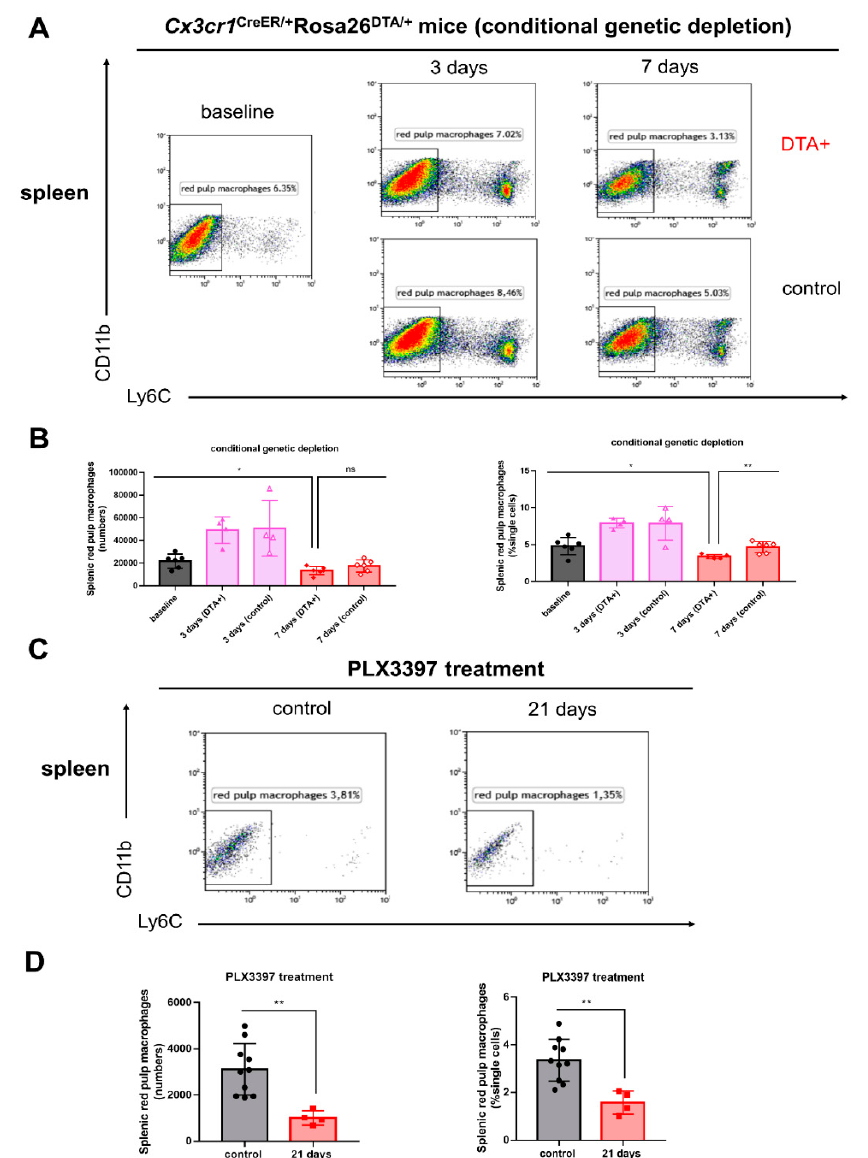
Figure 2. Splenic red pulp macrophages are reduced following both conditional genetic and pharmacological microglial depletion. ( A ) Representative flow cytometry plots of splenic red pulp macrophages in Cx3cr1 CreER /+ Rosa26 DTA /+ and Cx3cr1 CreER /+ mice at days 3 and 7 post tamoxifen injections. Red pulp macrophages were analyzed under the F4 / 80 hi gate. ( B ) The numbers and percentages of splenic red pulp macrophages ( ± SEM) during conditional genetic microglial depletion periods (baseline, black bars; day 3, pink bars; day 7, red bars, n = 6, 4, 4, 6, 6, respectively). ( C )